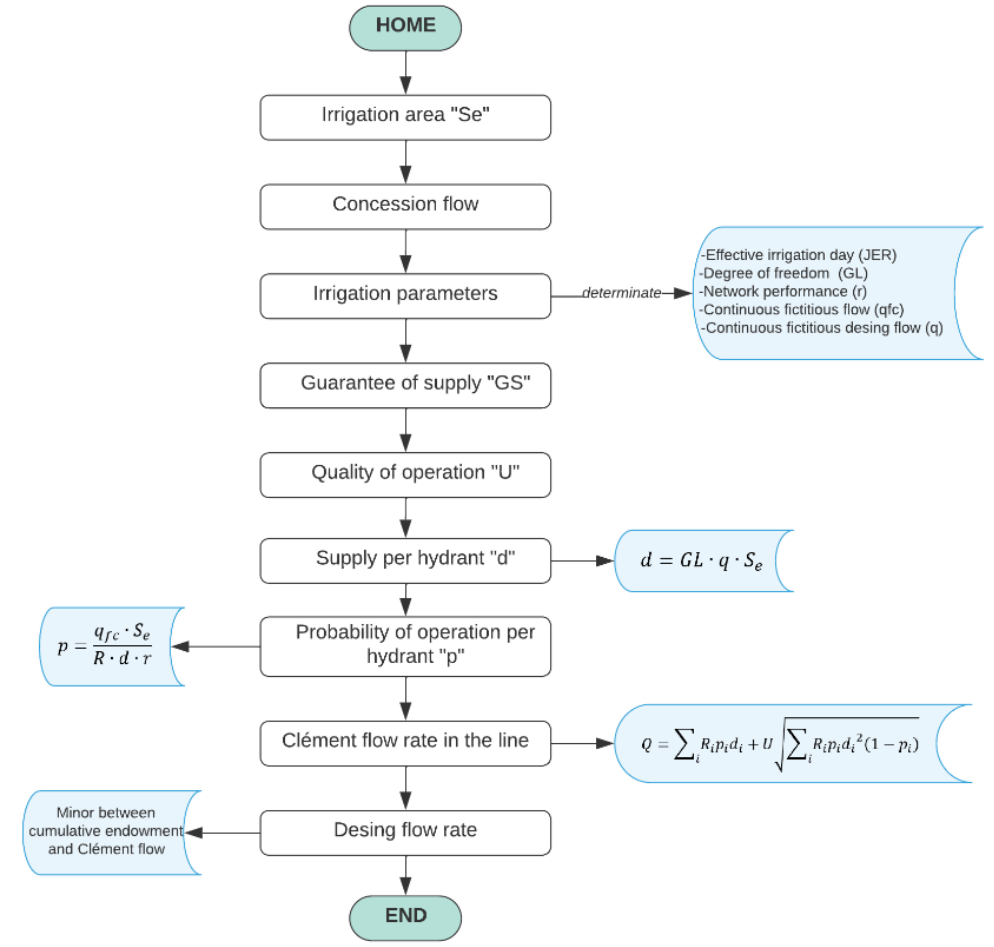
Figure 3. Flowchart of the design flow on-demand procedure.